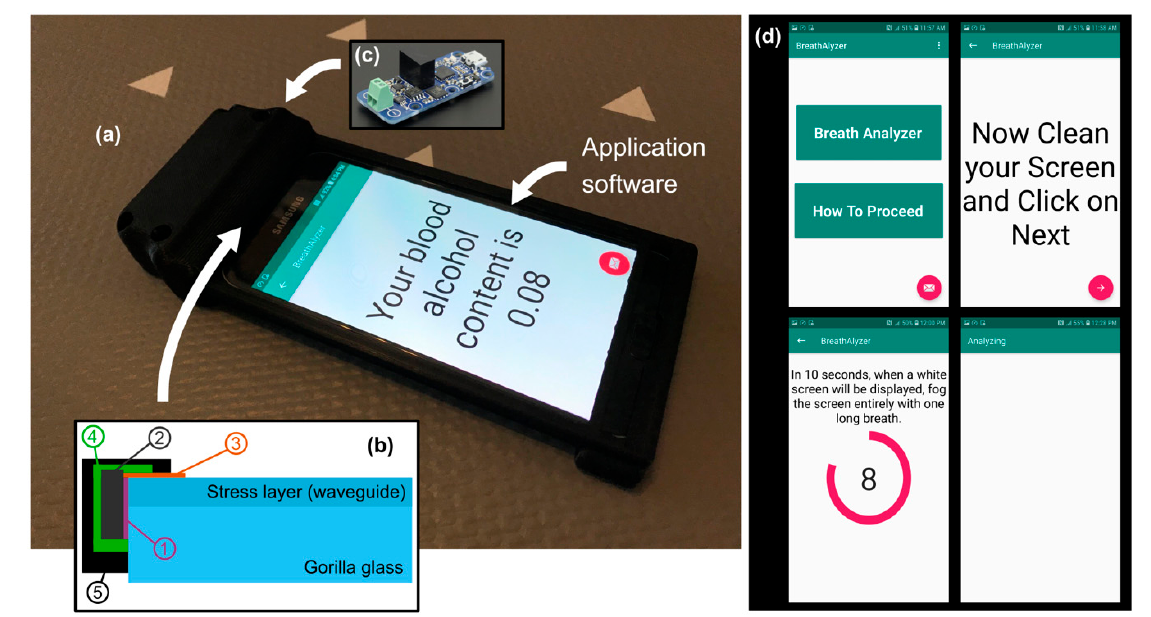
Figure 2. The optical breathalyzer prototype. ( a ) Photograph of our prototype. ( b ) Scheme of the photodiode installation on the side of the glass screen. ( c ) The electronics. ( d ) Screenshots of the application software steps before displaying the BAC result shown in ( a ).